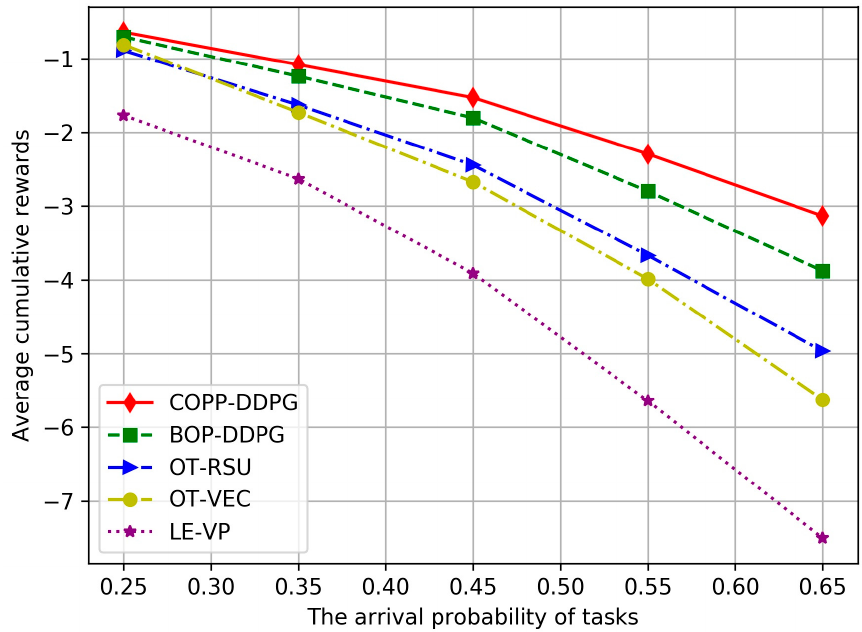
Figure 6. Comparison of five algorithms with different arrival probabilities of tasks 𝑃 (cid:3047)(cid:3028)(cid:3046)(cid:3038)(cid:3028)(cid:3045)(cid:3045) .